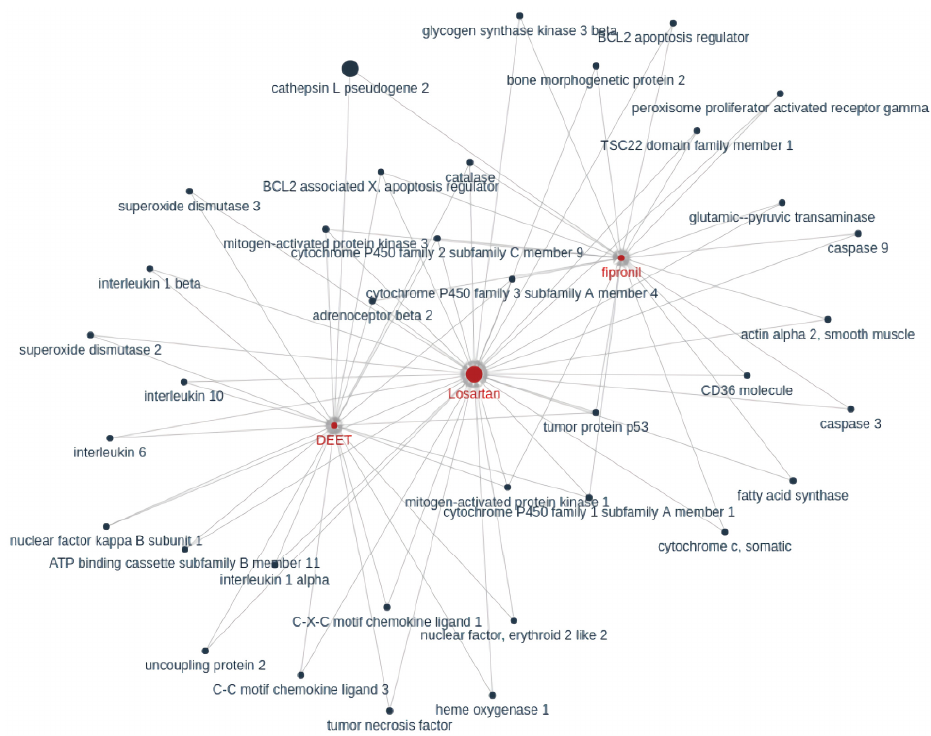
Figure 2. Constructed KG connecting losartan (candidate drug in COVID-19) and cathepsin L pseudogene 2 (gene related to coronavirus). Reproduced with permission from Wang et al. [23].